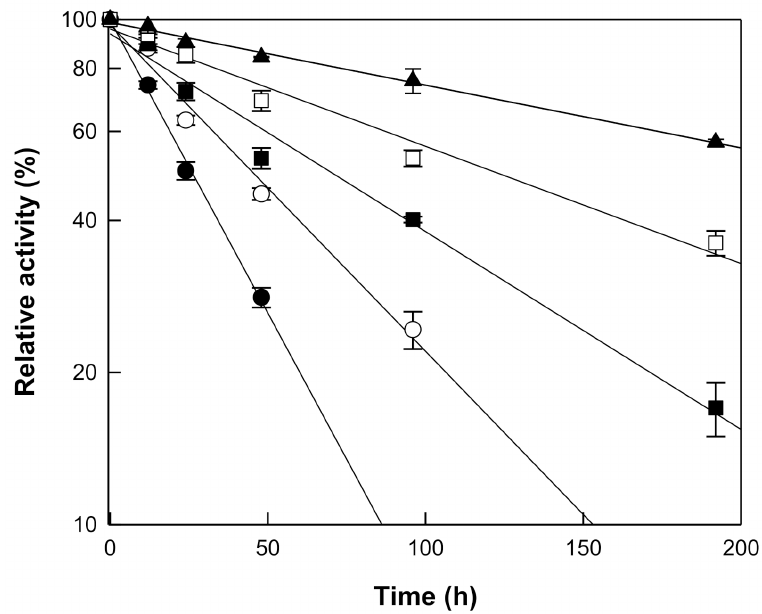
Figure 3. Thermal inactivation of β -galactosidase from T. uzoniensis . The enzyme was incubated at 75 (closed triangle), 80 (open square), 85 (closed square), 90 (open circle), and 95 ◦ C (closed circle) in 50 mM CPB (pH 5.0) for different time periods and the residual activity was determined. Data are represented as the means of thriplicate experiments and error bars represent the standard deviation.